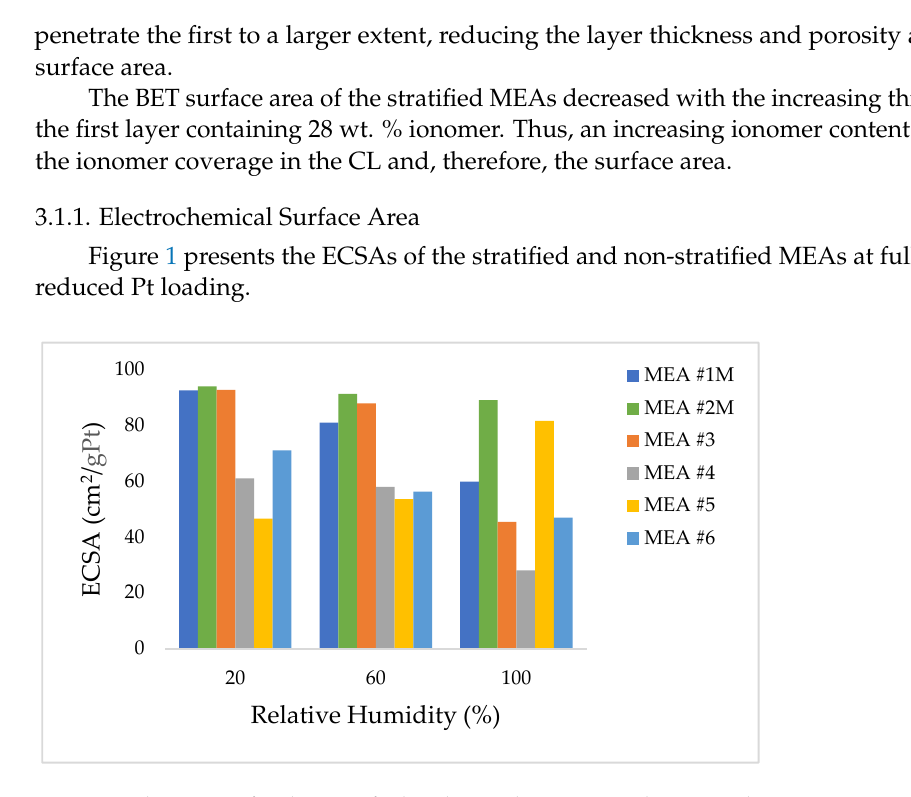
Figure 1. The ECSAs for the stratified and monolayer MEAs determined at 20 – 100% RH. The monolayer MEA #2M, with reduced Pt loading, demonstrated the largest and most consistent ECSA under all RH conditions (94.11 m 2 /g Pt , 91.52 m 2 /g Pt , and 89.19 m 2 /g Pt ), owing to its highly porous agglomerate structure. No trend in ECSA was observed for the increase or decrease in ionomer-loaded layer thickness. The stratified CCL MEA with the largest BET surface area and more 24 wt. % I loading (MEA #3) demonstrated a larger ECSA from 20 to 60% RH conditions (92.92 m 2 /g Pt and 88.04 m 2 /g Pt ) and low porosity and surface area. MEA #5 showed the highest ECSA (81.81 m 2 /g Pt ) of the stratified MEAs at